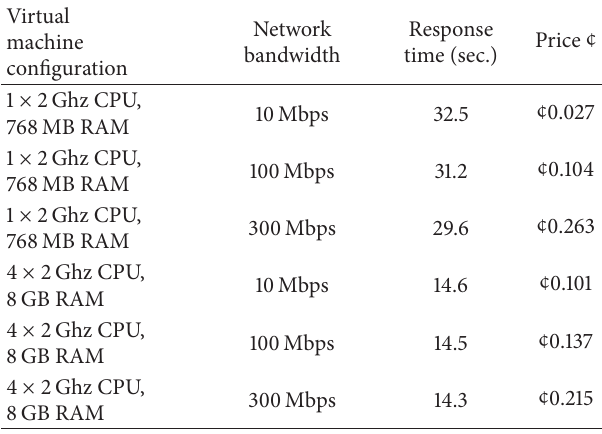
Table2:ResponsetimeandmonetarycostsofTPC-Hquery3(QP with 6 different virtual resource